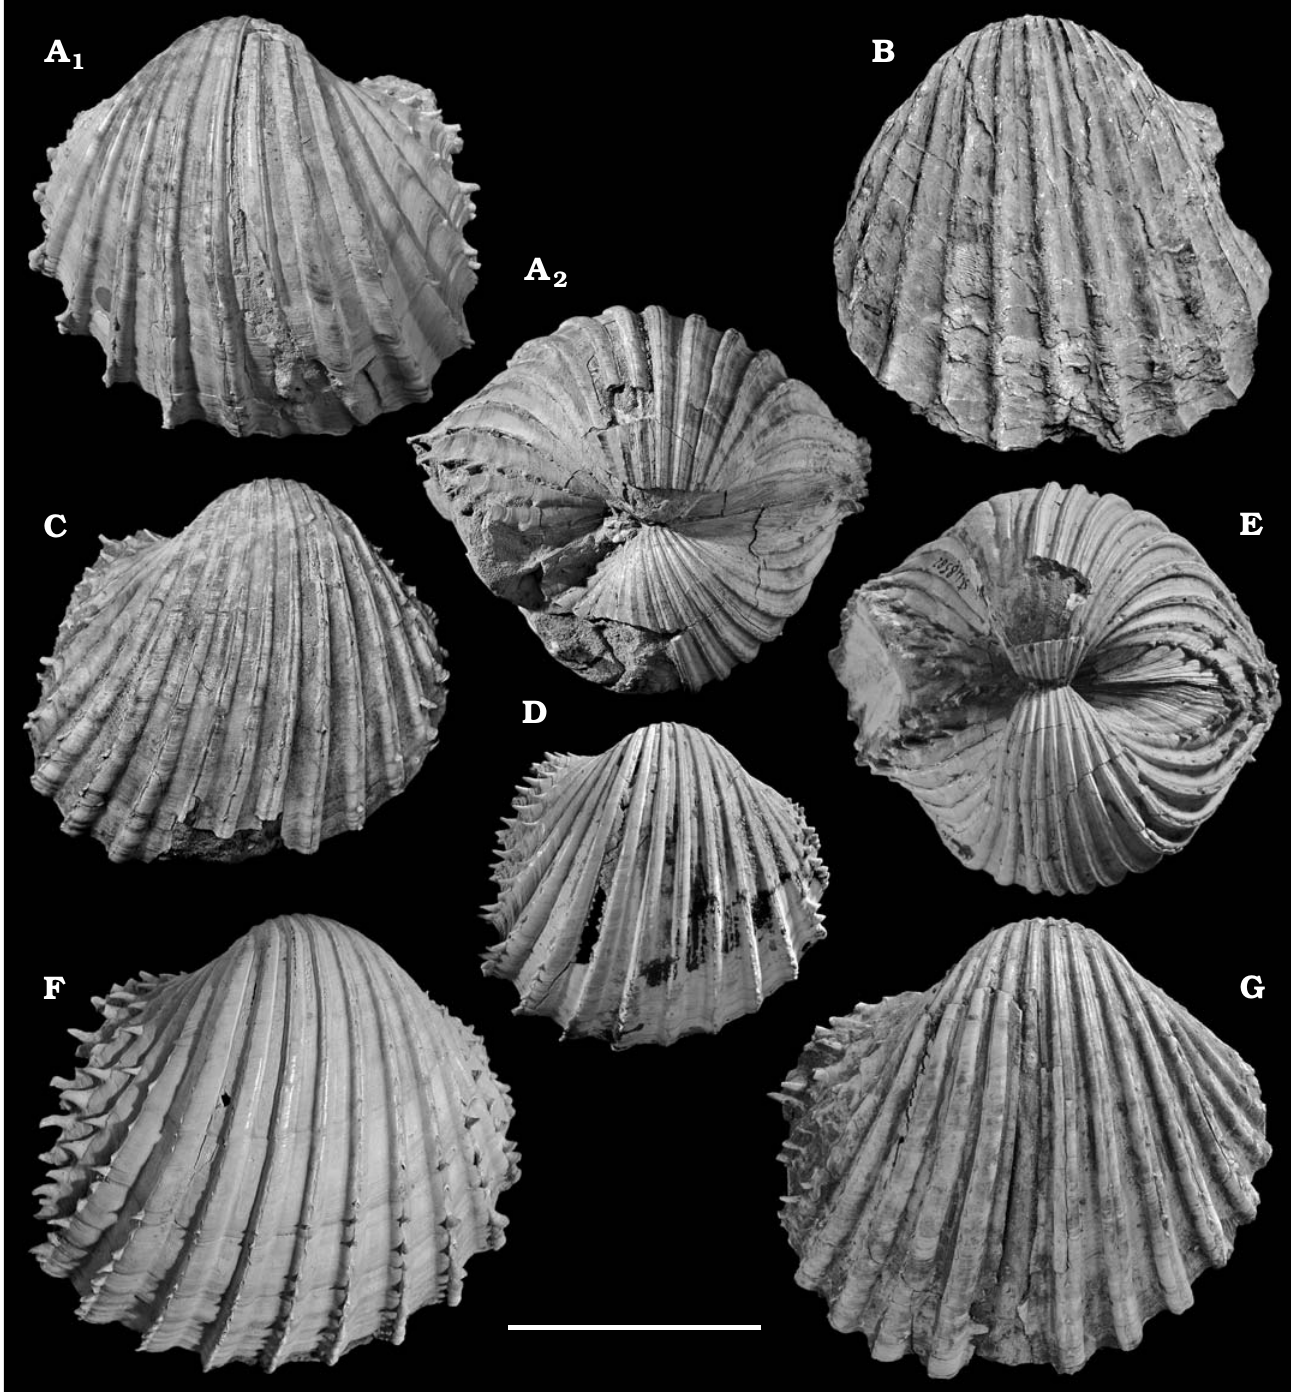
Fig. 3. Cardiid bivalve Procardium diluvianum (Lamarck, 1819). A . Syntype of Cardium hians Brocchi, 1814, MSNM i13317, Pliocene, northern Italy (photo Giorgio Teruzzi); external (A 1 ) and umbonal (A 2 ) views. B . Holotype of Cardium diluvianum Lamarck, 1819, MNHN.F.A50147, Pliocene, surroundings of Siena, Italy; external view (photo Jacques Mouchart, http://coldb.mnhn.fr/catalognumber/mnhn/f/a50147). C . MPUR no registration number (unnumbered Cerulli Irelli collection), Early Pleistocene, Farnesina, Italy; external view. D . RGM.794093 (van Nieulande collection), Zanclean (Pliocene), Bonares, Spain; external view. E . RGM.48582.a, Piacenzian (Pliocene), Castell’Arquato, Italy; umbonal view. F . MRSN BS.131.03.001, Pliocene, Asti Hills, Italy; external view. G . RGM.48583, Piacenzian (Pliocene), Castell’Arquato, Italy; external view. Scale bar 50 Brocchi (1814: 508, pl. 13: 6) described C . hians from 17 distantibus, antice depressis, aculeatis, postice tuberculis raris cochleariformibus instructis, valvis anterius hiantibus, margine hiatus profundissime serrato”. The figured syntype